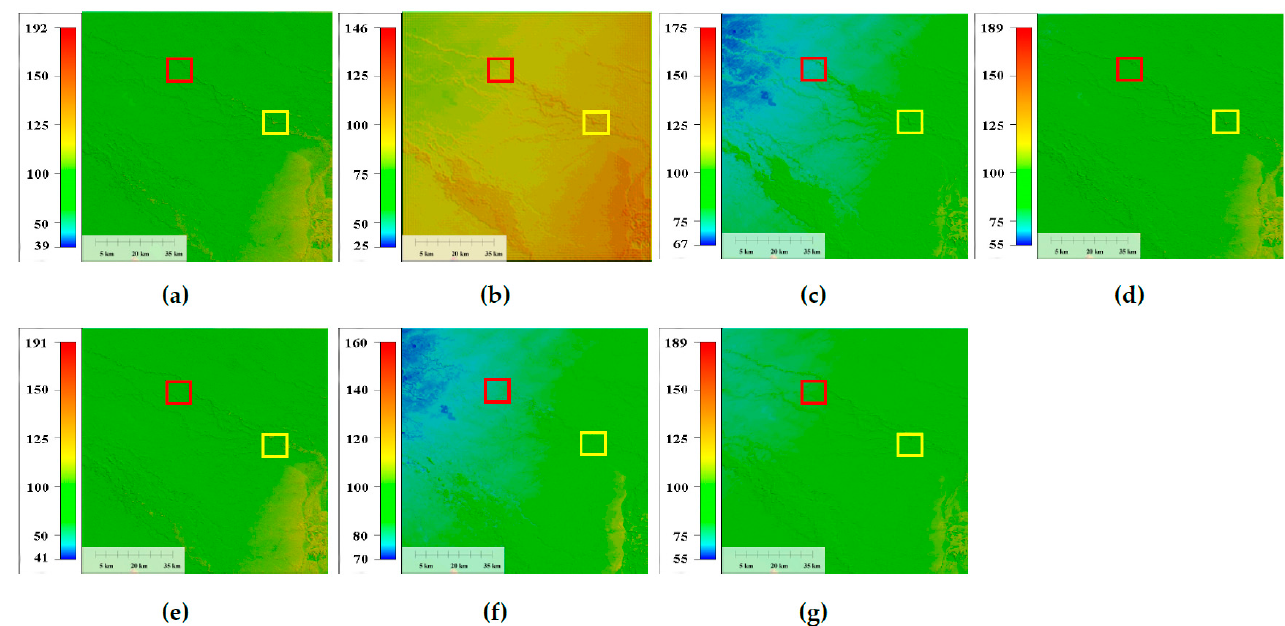
Figure 14. Results of the real experiment for area S36E144 (unit: meter). ( a ) Original area S36E144, ( b ) low-pass filter, ( c ) TV, ( d ) UTV, ( e ) LRSID, ( f ) Gallant and ( g ) LRGS.